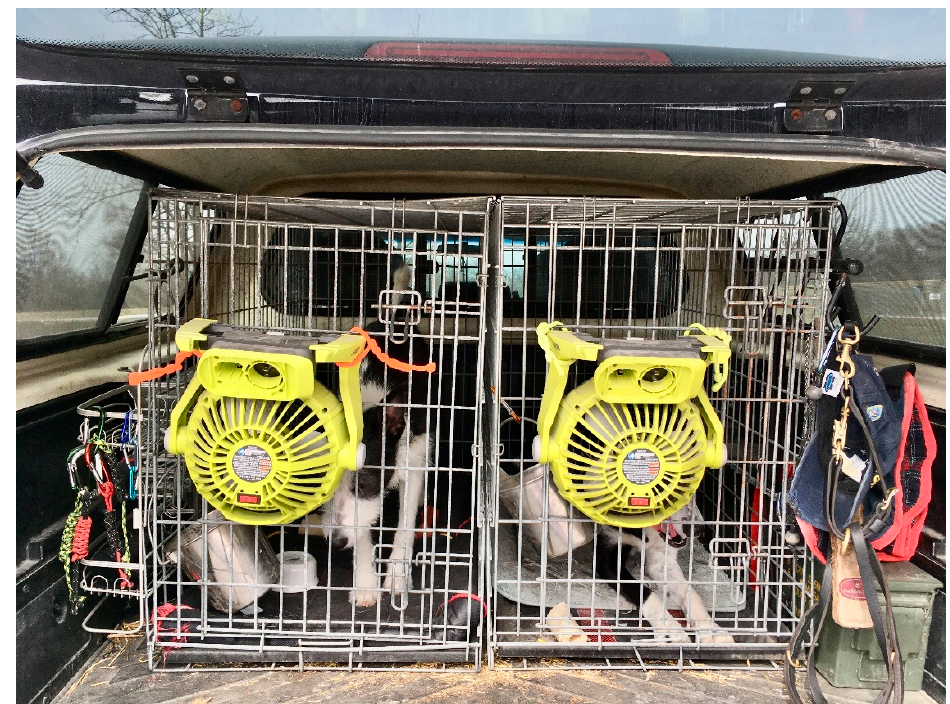
Figure 3. Pick-up truck with camper shell and dual crate system with battery operated mounted fans.